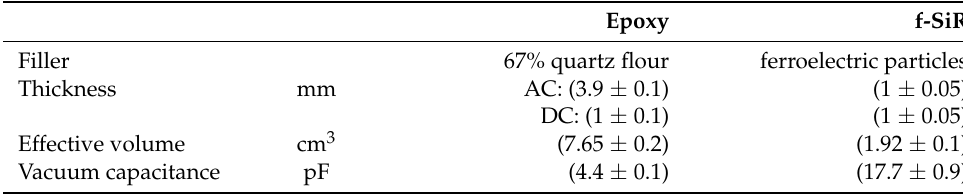
Table 1. Samples and their characteristics. f-SiR, functionally filled silicone rubber.